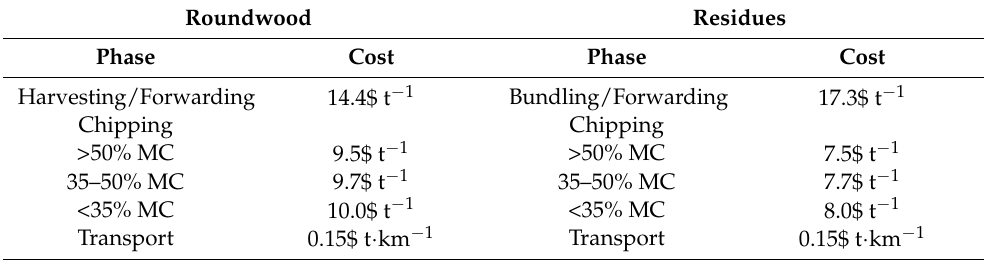
Table 3. Harvesting, transport, and chipping costs for roundwood and residues used in the